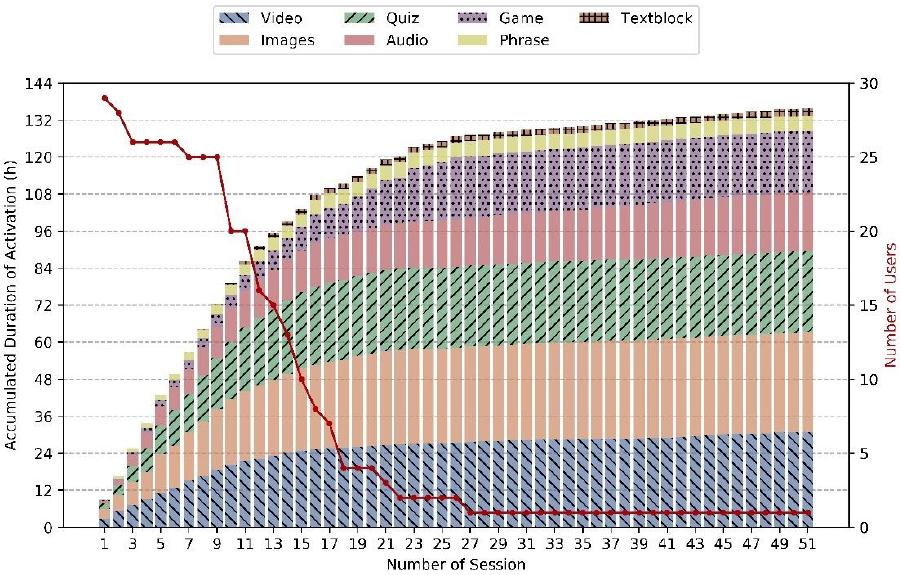
Figure 4. Accumulated duration [hours] of I-CARE activation sessions in the evaluation study.